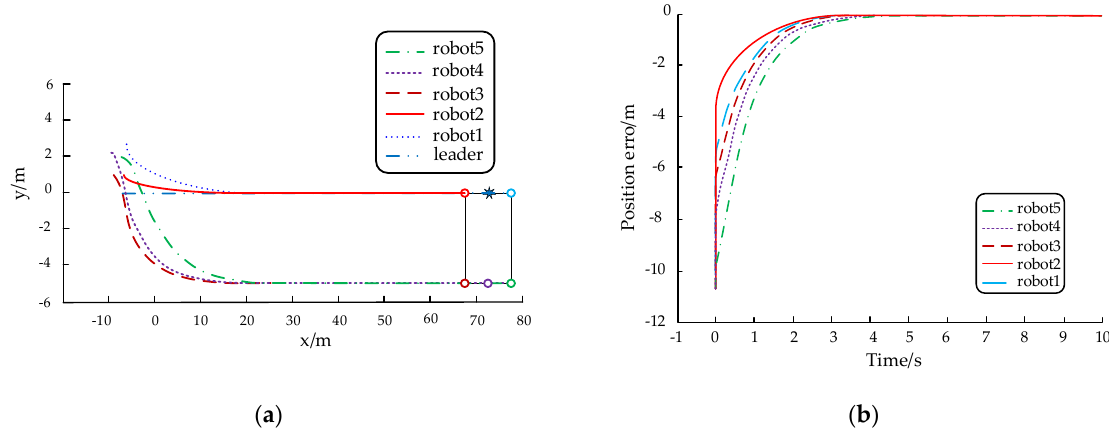
Figure 10. ( a ) Trajectory of rectangular formation by GCF; ( b ) Position error of rectangular formation over time.